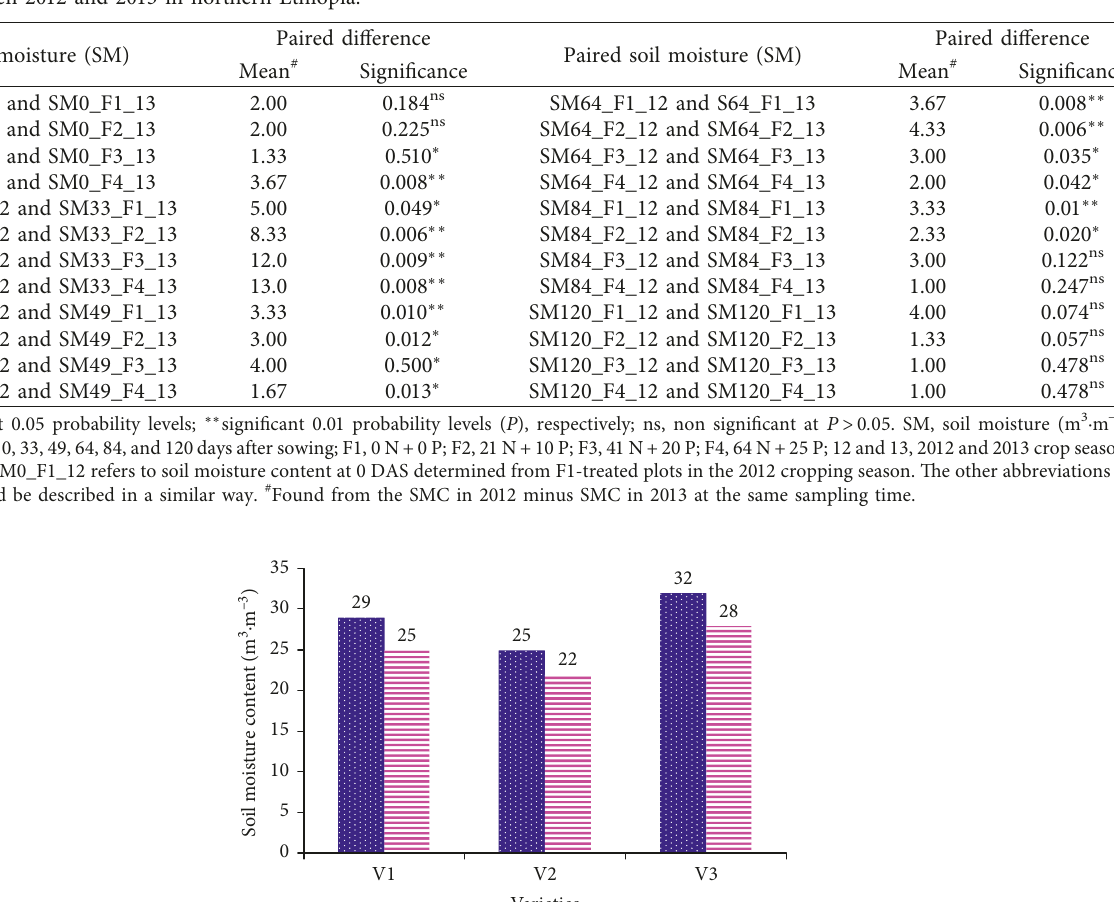
Table 7: Paired-samples T -test results of the separate effects of fertilizer rates on soil moisture determined at same sampling times under tef crops between 2012 and 2013 in northern Ethiopia.